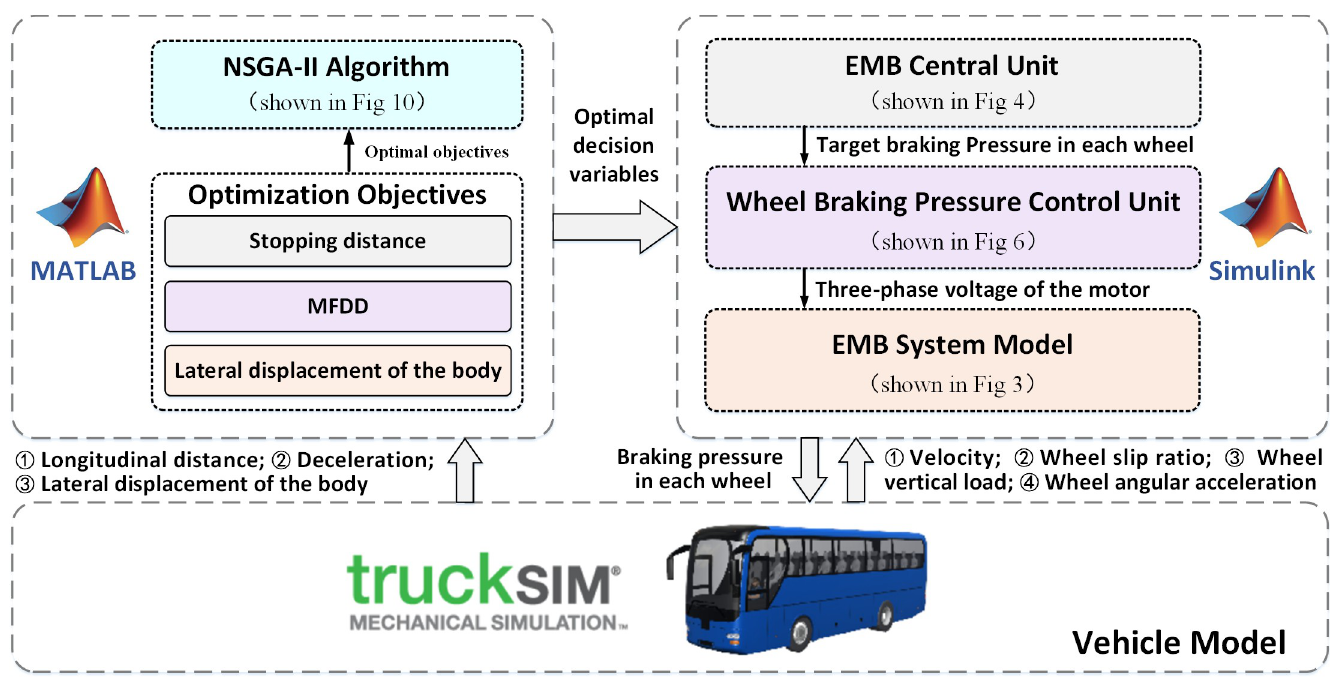
Fig 11. Co–simulation platform for the EMB parameters